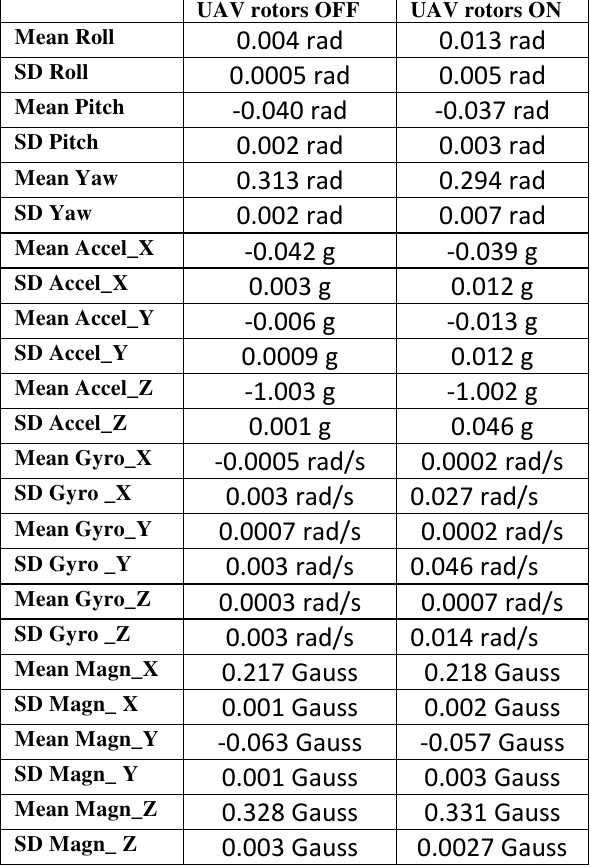
Table 2. Mean and SD values of inertial sensor values with UAV rotors off and on with static